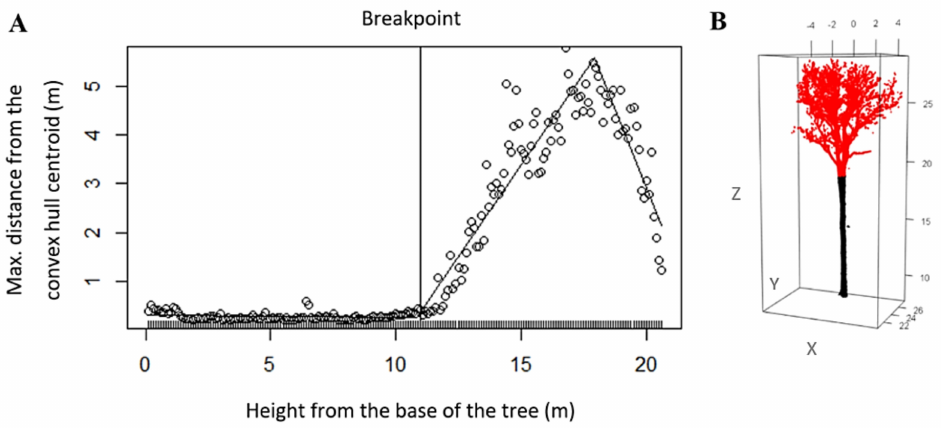
Figure 9. Crown-based height ( CBH ) identification of a tree that was delineated from the ULS-V- Pcloud using the method proposed by [106]. ( A ) The CBH is defined as the lowest breakpoint of the segmented regression, which corresponds to the point where the maximum distance from the convex hull centroid starts increasing sharply because of the presence of branches; ( B ) crown points are identified in red (i.e., points above the CBH ) on the delineated point